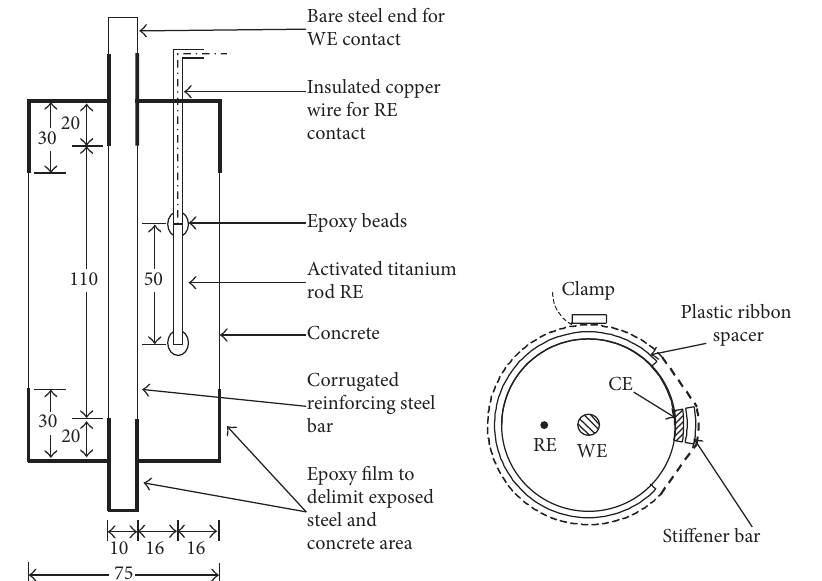
Figure 1: Specimen